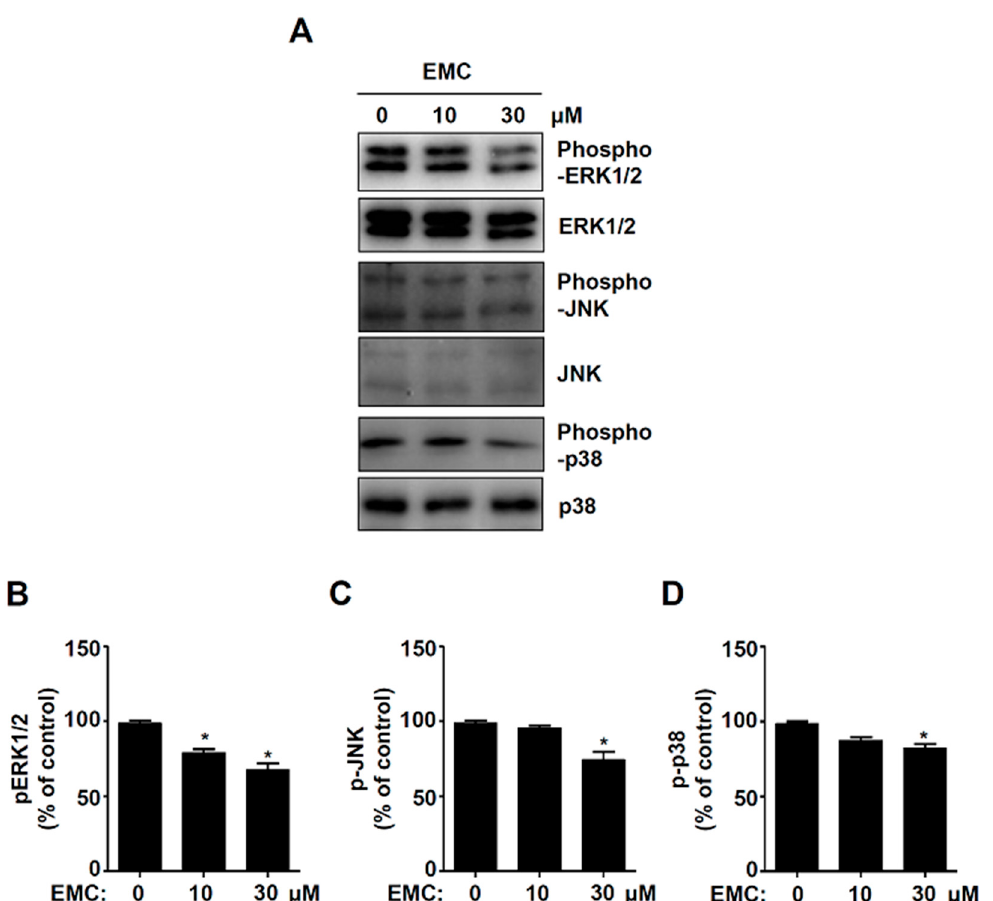
Figure 5. EMC decreases MAPKs signaling in pre-osteoblasts. ( A – D ) 24 h after EMC treatment, phoshpho-ERK1 / 2, ERK1 / 2, phospho-JNK, JNK, phospho-p38, and p38 were detected by western blot analysis. The levels of the phoshpho-ERK1 / 2 ( B ), phospho-JNK ( C ), and phospho-p38 ( D ) were represented as relative percentages of the control after normalization of the phosphorylation level by the total level (ERK1 / 2, JNK, and p38). The data are expressed as the mean ± S.E.M. of experiments. * ( p < 0.05) indicates statistically significant di ff erences compared to the control.